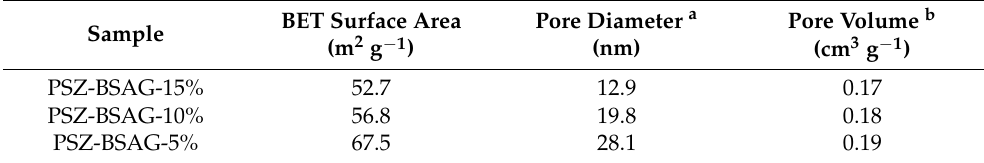
Figure 3. ( a ) Nitrogen adsorption–desorption isotherm and ( b ) pore size distribution of polymer- derived aerogels (PSZ-BSAGs) prepared with different solution ratios. Table 1. Pore structure data (characterized by the Brunauer–Emmett–Teller (BET) method) of polymer-derived aerogels (PSZ-BSAGs).